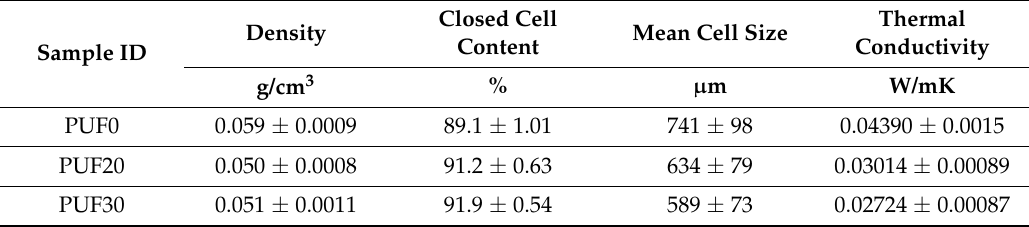
Table 2. Foam structure and physical